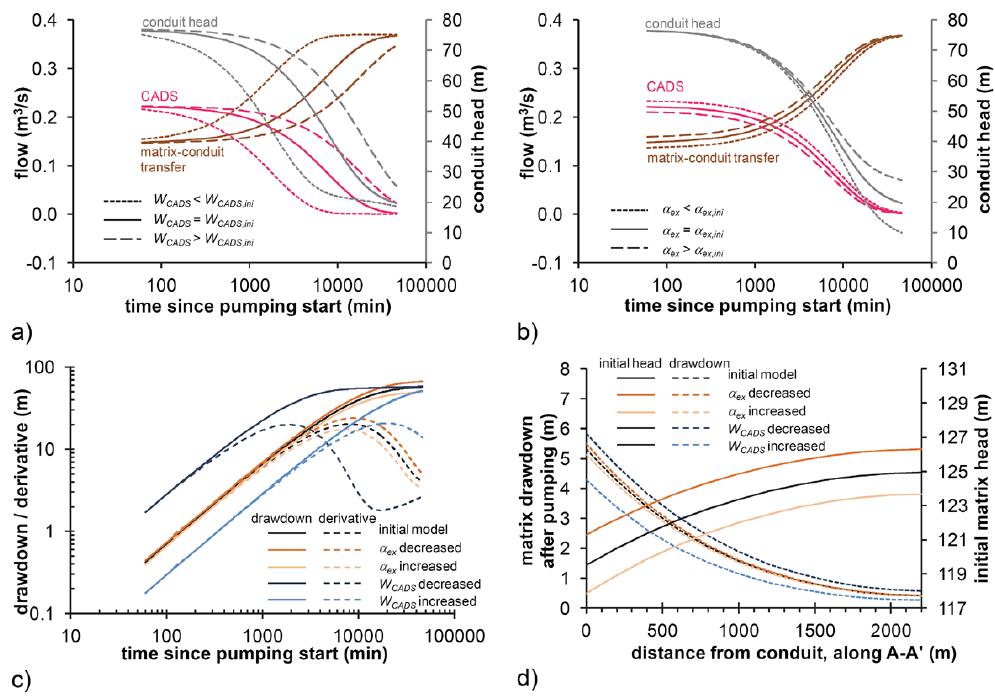
Fig. 10. Simulation results for the large-scale pump test scenario: (a) flow terms for variable CADS; (b) flow terms for variable matrix– conduit transfer; (c) log-log diagnostic plot for conduit drawdown and drawdown derivatives at node 5; (d) initial matrix head and matrix drawdown at day 38 along the cross section A–A’ (Fig. 9), note that initial heads for models with varying W CADS are the